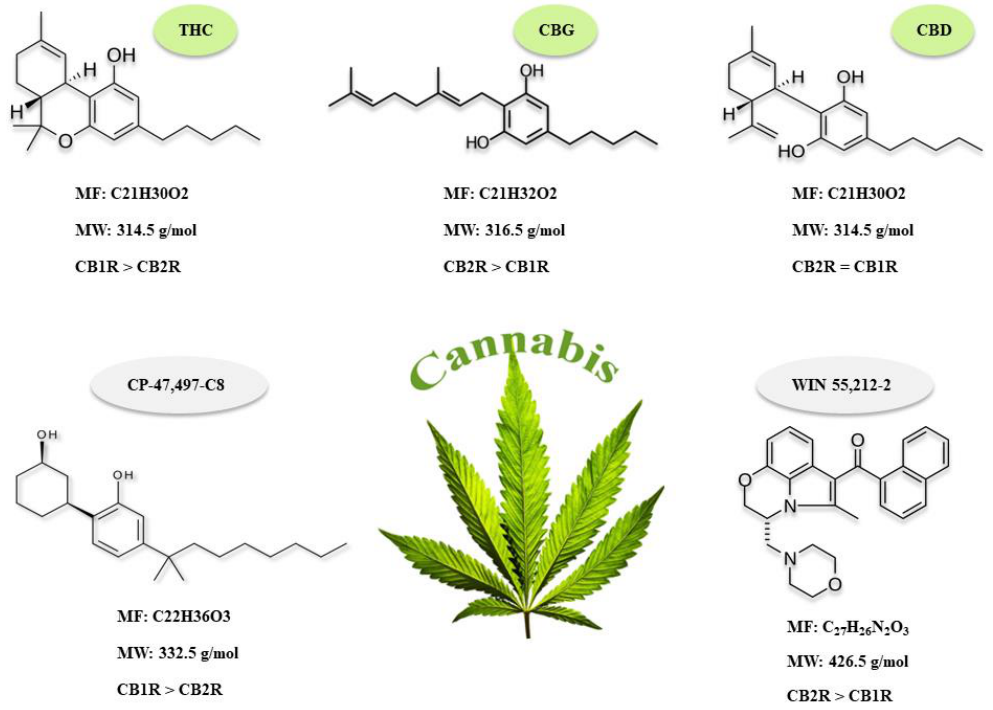
Figure 2. Chemical structures, molecular formula (MF), molecular weight (MW) and the affinity for CB1R and CB2R of the three natural components of cannabis including: Tetrahydrocannabinol (THC), Cannabidiol (CBD), Cannabigerol (CBG) and two synthetic cannabinoids known as CP-47,497-C8 and WIN 55,212-2.